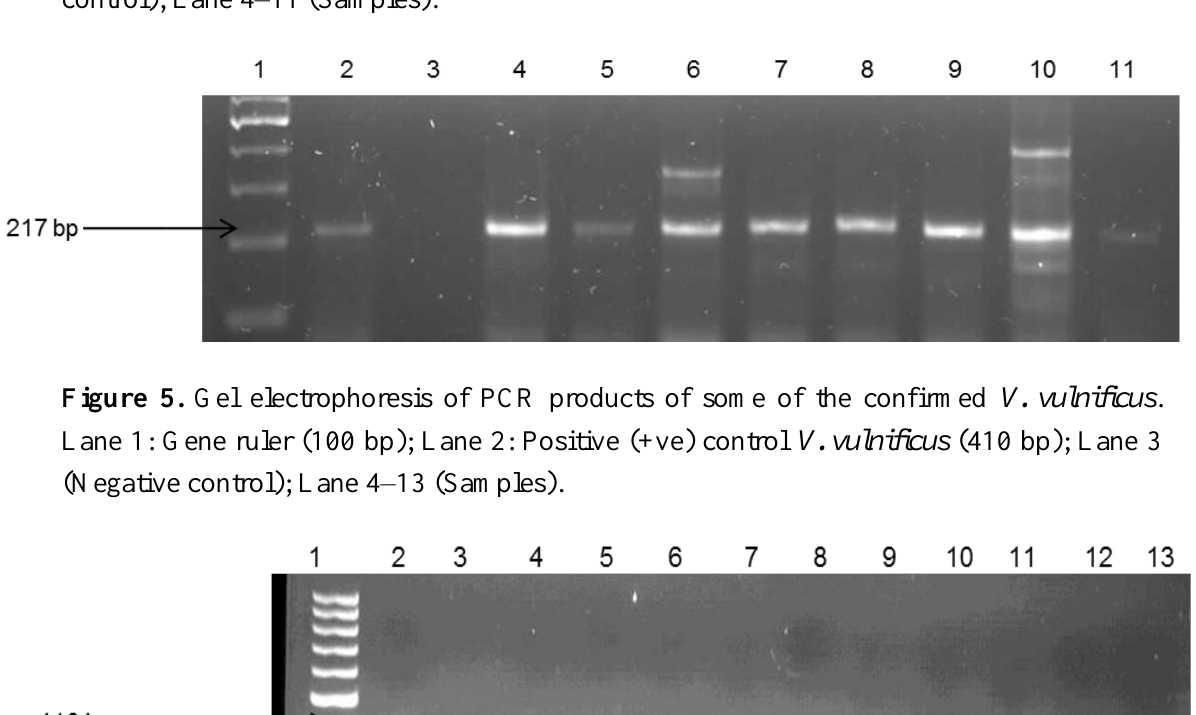
Figure 4. Gel electrophoresis of PCR products of some of the confirmed V. fluvialis . Lane 1: Gene ruler (100 bp); Lane 2: Positive control ( V. fluvialis DSM 19283 ) ; Lane 3 (Negative control); Lane 4–11 (Samples).